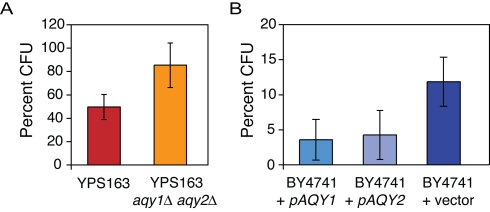
Strains lacking AQY genes show a fitness advantage under high osmolarity.Cells were grown on solid agar plates containing 1.5 M sorbitol for 2 days and the number of colony-forming units (CFU) was compared to a no-stress control plate. (A) CFU for YPS163 and YPS163 aqy1Δ aqy2Δ grown on rich medium plus 1.5 M sorbitol; (B) S288c-derivative BY4741 harboring the empty vector or a plasmid expressing the YPS163 allele of AQY1 or AQY2, grown on selective medium with 1.5 M sorbitol. The average and standard deviation of biological triplicates is shown.